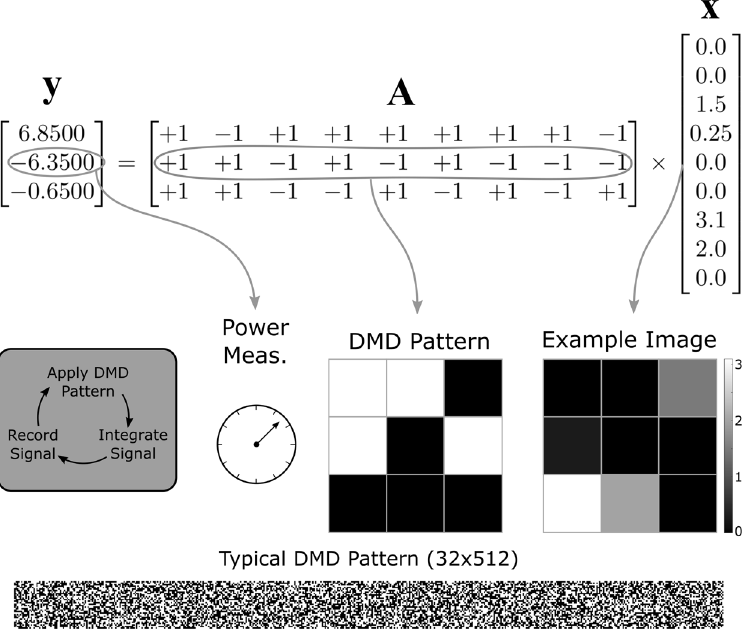
Figure 1. Visualization of compressive sensing. For clarity, we consider a 3 × 3 example image ( N = 9) with a 33% measurement rate ( M = 3). This image is 4-sparse, i.e., has only four non-zero elements. The image is flattened to 1D and represented as the length-9 vector x . The 3 × 9 measurement matrix is a random sequence of ± 1s; each row corresponds to a pattern on the DMD. Black pixels on the DMD represent light going to detector 1, while white pixels represents light going to detector 2. The measurement result is an element in vector y and is obtained physically by subtracting the power incident upon detector 1 from the power incident upon detector 2. If only one detector is used, the sensing matrix becomes a series of 1s and 0s instead. In an experiment, y is measured, A is known, and x is found via reconstruction. A typical DMD pattern is shown for the 32 512 × Raman images